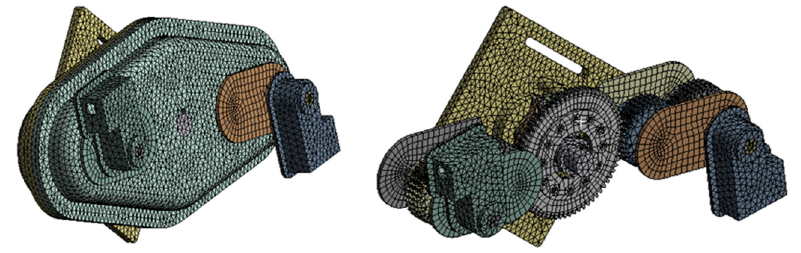
Figure 10. Grid model of seedling picking mechanism.